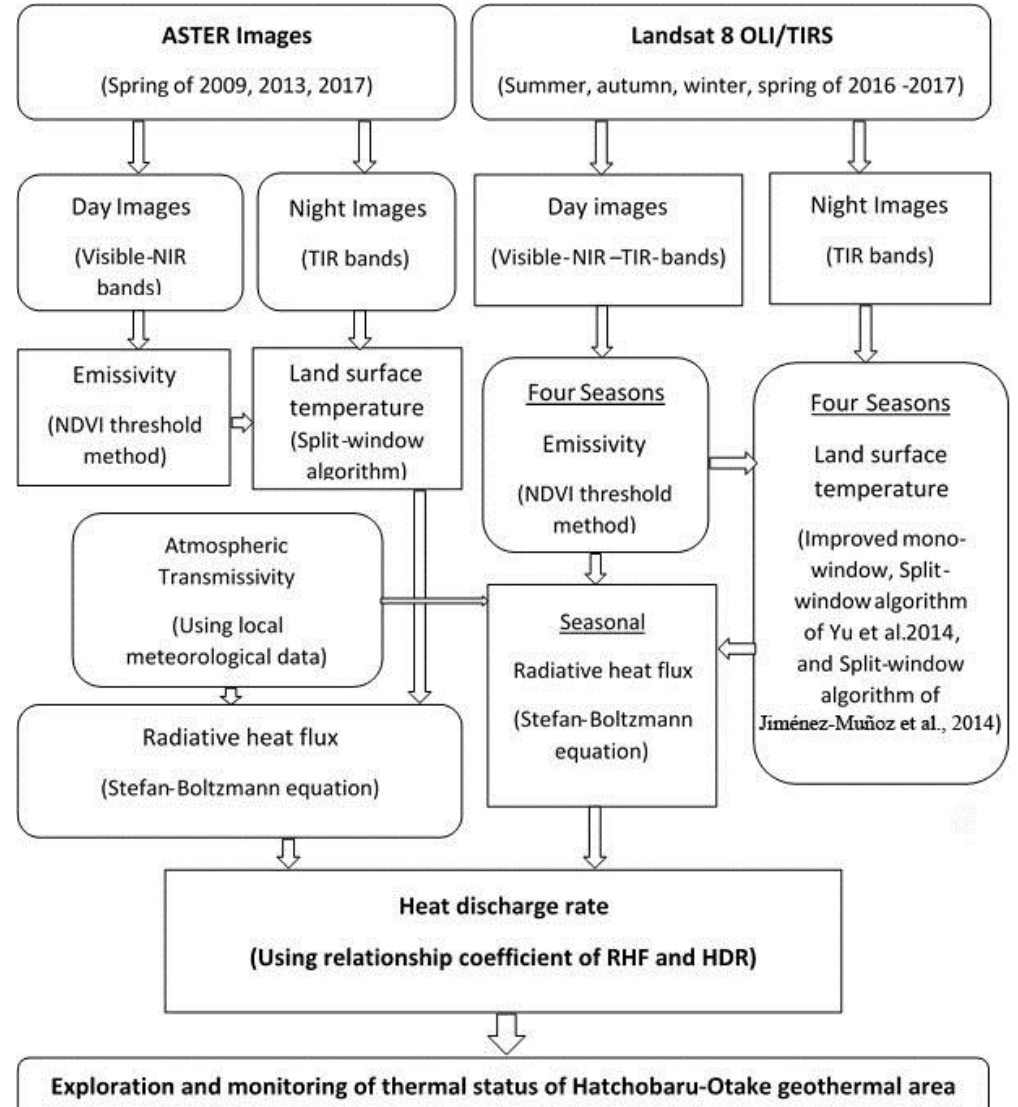
Figure 3. Satellite image processing flow chart used in this study. Daytime and nighttime images from both satellite sensors were used to calculate the emissivity and land surface temperatures using the various methods listed above. NIR—near infrared; TIR—thermal infrared; NDVI—normalised difference vegetation index; RHF—radiative heat flux; HDR—heat discharge rate.